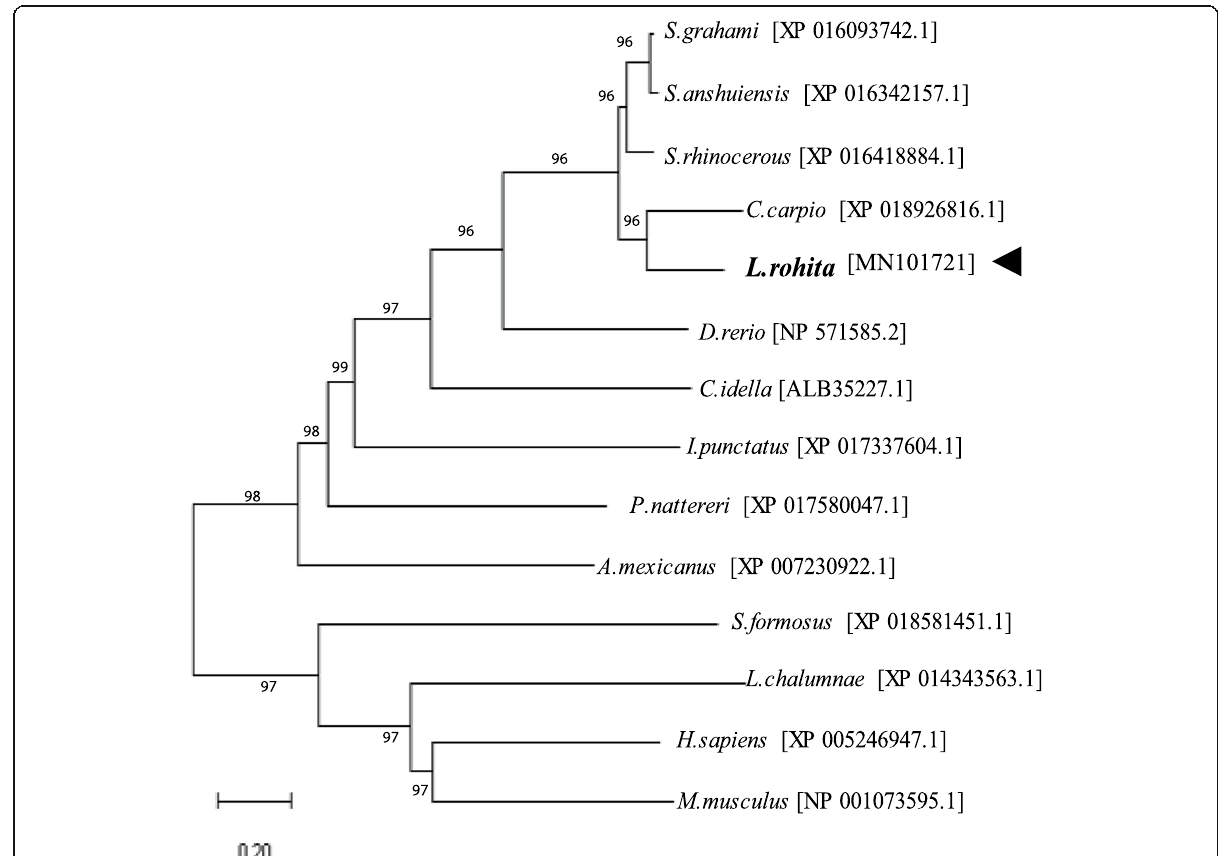
Fig. 4 Phylogenetic relationship of rohu caspase-8 with other animal species. Full-length caspase-8 amino acid sequences of various animal species were retrieved from the GenBank (acc. no. mentioned inside the bracket), and the un-rooted phylogenetic tree was generated by the neighbor-joining method within the MEGA-X